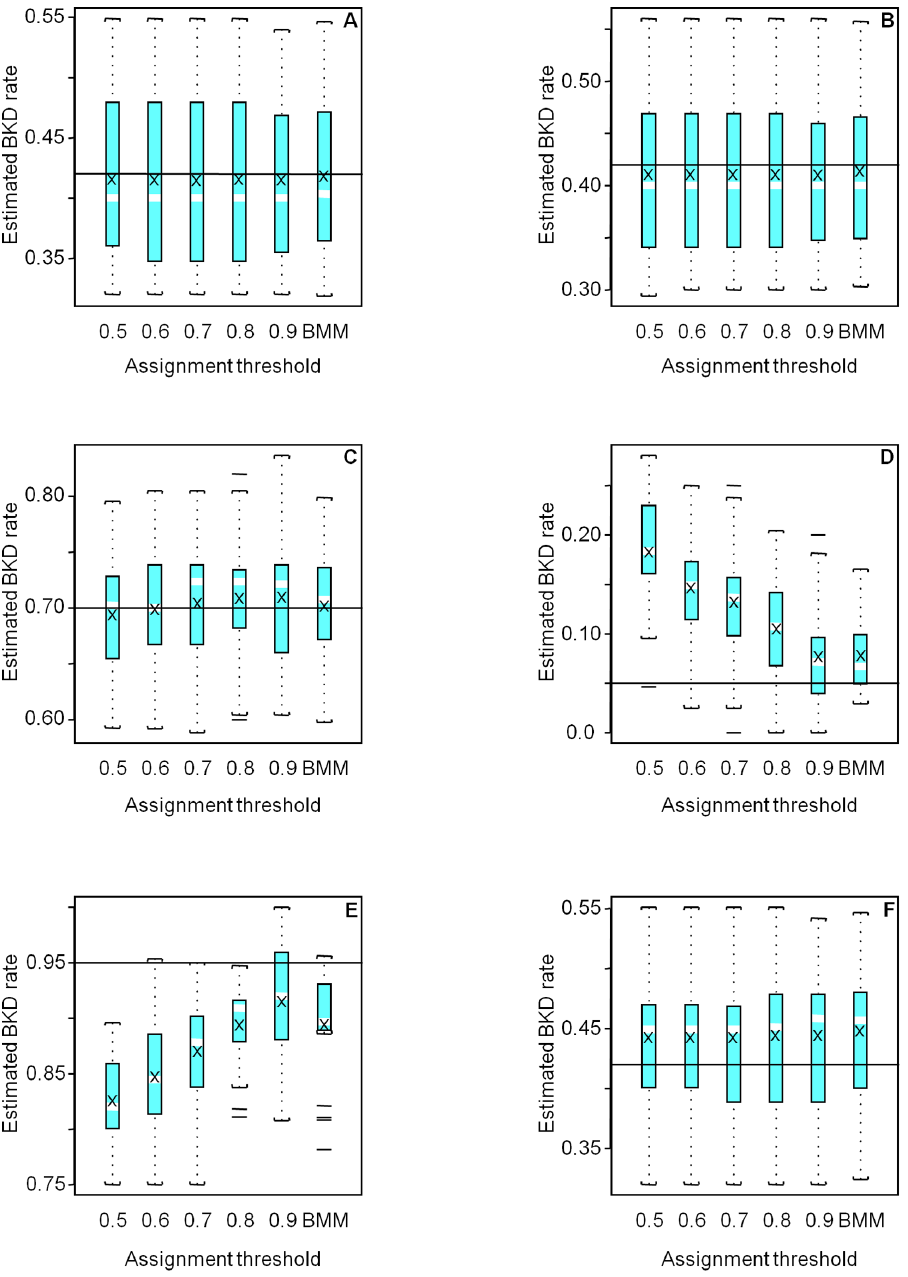
Figure 2. Boxplots of the estimated BKD prevalence rates for the 25 simulations of the negative case in Groups (A) 1, (B) 2, (C) 3, (D) 4, (E) 5, and (F) 6, using the individual assignment method and minimum assignment probability thresholds from 0.5 to 0.9. BMM represents the Bayesian mixture model, and the X marks the mean estimate. The solid line indicates the true BKD prevalence rate. Note the scales of the y axes